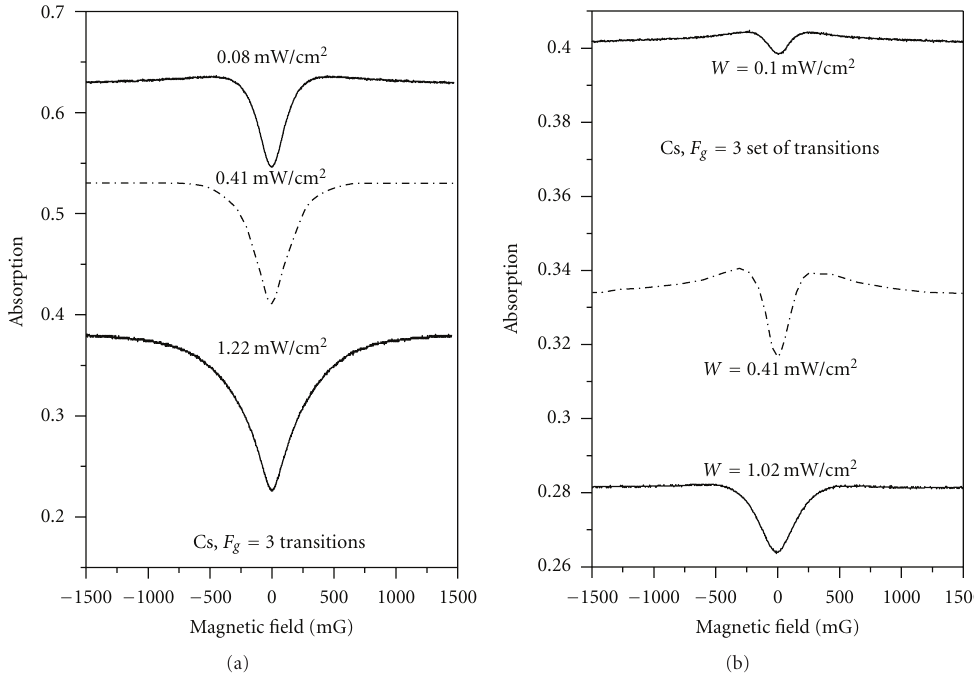
Figure 3: CPT dark resonance profile with laser power density enhancement observed at the F g = 3 set of transitions: (a) conventional cell with L = 2 . 5cm and atomic source temperature T = 22 ◦ C; (b) thin cell with L = 700 μ m at T = 34 ◦ C. In both cells, no resonance sign change is observed.